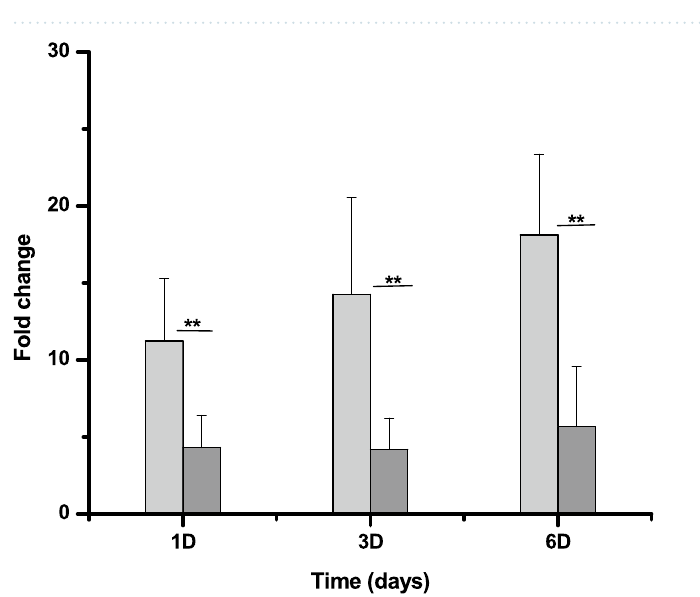
Figure 3. Quantification of MRA2164 and MRA0854 genes expression in nitrite treated Mycobacterium tuberculosis cells: The total RNA was extracted from untreated and nitrite (1, 3 and 6 days) treated Mtb cells and reverse transcribed into cDNA. Relative quantification done by using SYBR green based qPCR kit and fold change was calculated compared to untreated Mtb where SigA gene was used as a housekeeping reference. The light gray and gray color shows the fold change of MRA2164 gene and MRA0854 gene respectively. The data represented as the mean of three experiments ± SD (** P <